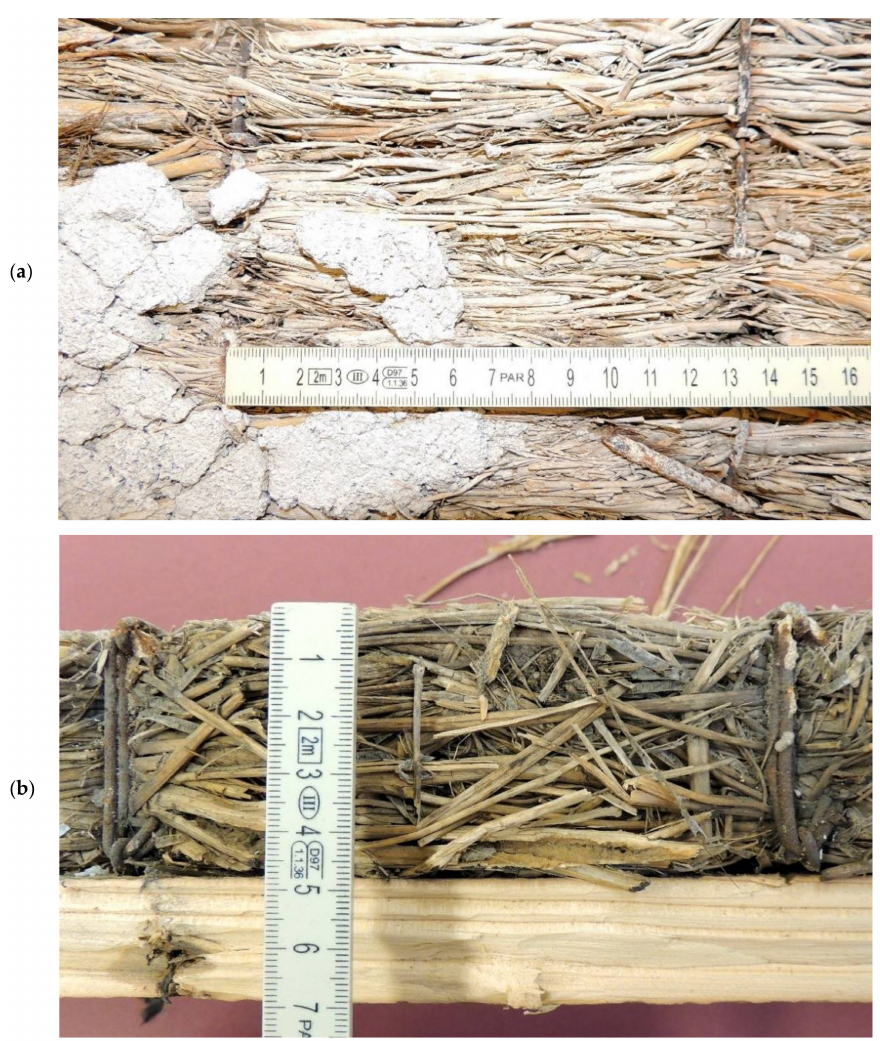
Figure 5. The tested SOLOMIT sample—cut rapeseed straw, binding with steel staples and the remains of the wooden structural frame and plaster: ( a ) surface of the panel, and ( b ) cross-section of the